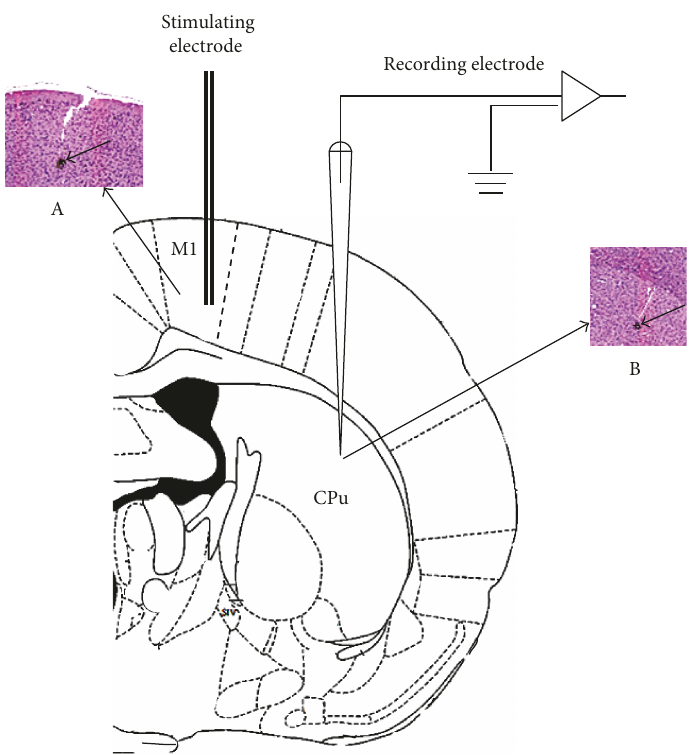
Figure 3: Schematic diagram of the positions of the recording electrodes and stimulating electrodes in the rat brain. M1: primary motor cortex. CPu: caudate putamen. A: haemorrhagic spots induced by stimulating electrode fulgerization located in the M1 region. B: haemorrhagic spots induced by recording electrode fulgerization located in the CPu region. Table 1: Comparison of the ratio of left forelimb touches to the total number of touches to the cylinder